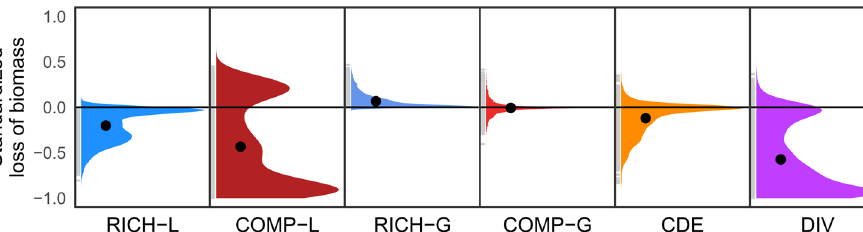
Fig. 3 Declines in fi sh biomass between sites are driven primarily by loss of species ( RICH-L ) and compositional losses ( COMP-L ). Panels show the frequency distributions of each component based on differences between sites with the highest biomass and other nearby sites. Values have been standardized to the interval ( − 1, 1). Black points represent the mean of all observations ±95% con fi dence intervals (which are too small to be observed). RICH richness, COMP composition, L loss, G gain, CDE context-dependent effect, DIV total diversity effect ( = RICH-L + COMP-L + RICH-G + COMP-G